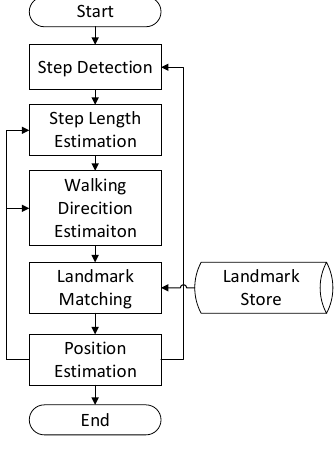
Figure 1. Flow chart of